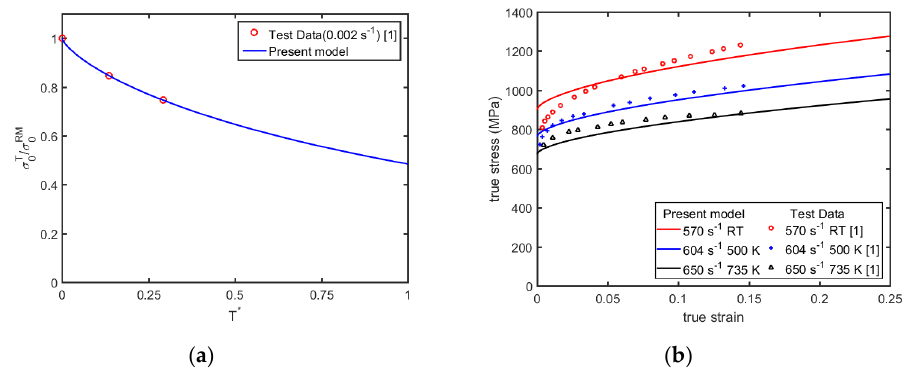
Figure 11. Comparison of the present model predictions with the tensile test data for 4340 steel. ( a ) σ 0 T / σ 0 Ta versus T * at a plastic strain of 0.05 under strain rate of 0.002 s − 1 ; and ( b ) true stress-true strain curves at elevated temperatures.